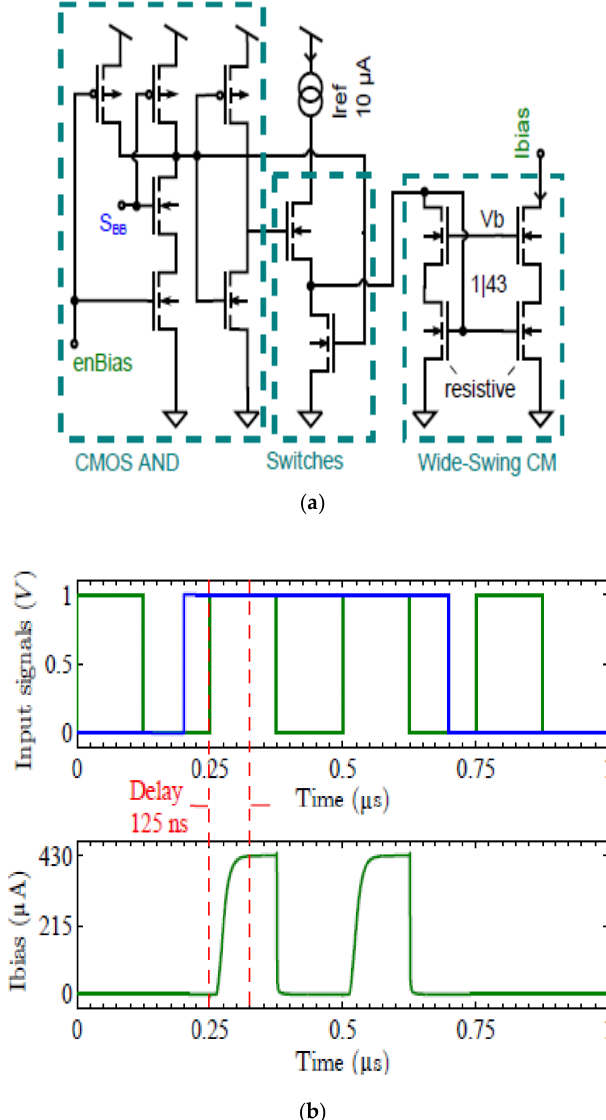
Figure 2 . ( a ) Circuit diagram of the bias current control logic, ( b ) Transient simulation of the switched bias control with input signals enBias (green), sBB (blue) on top and the output bias current Ibias at the bottom.